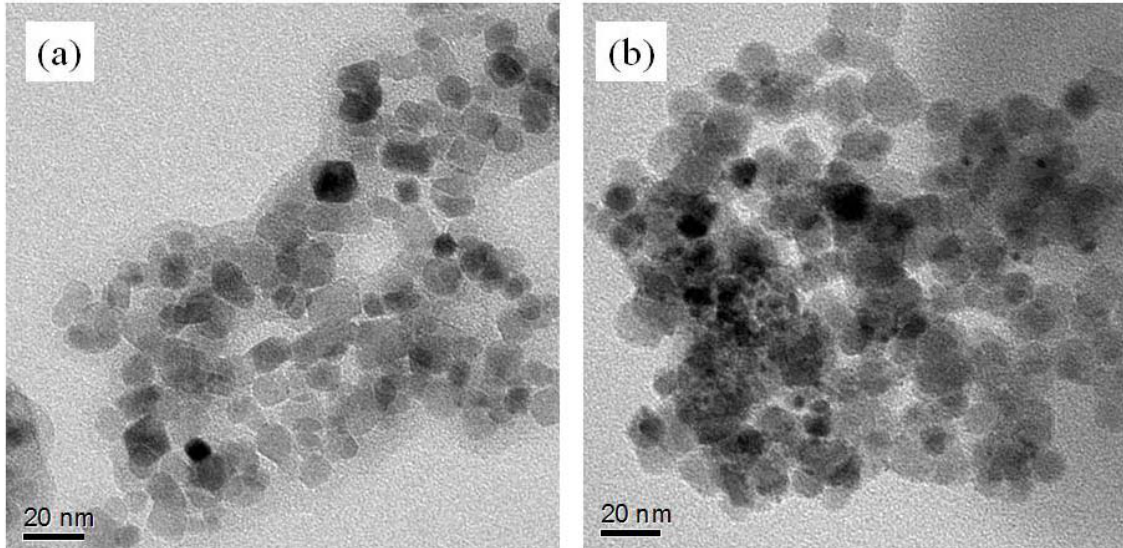
Figure 3. (a) TEM image of the Fe Fe O :PVP/Au 3 4